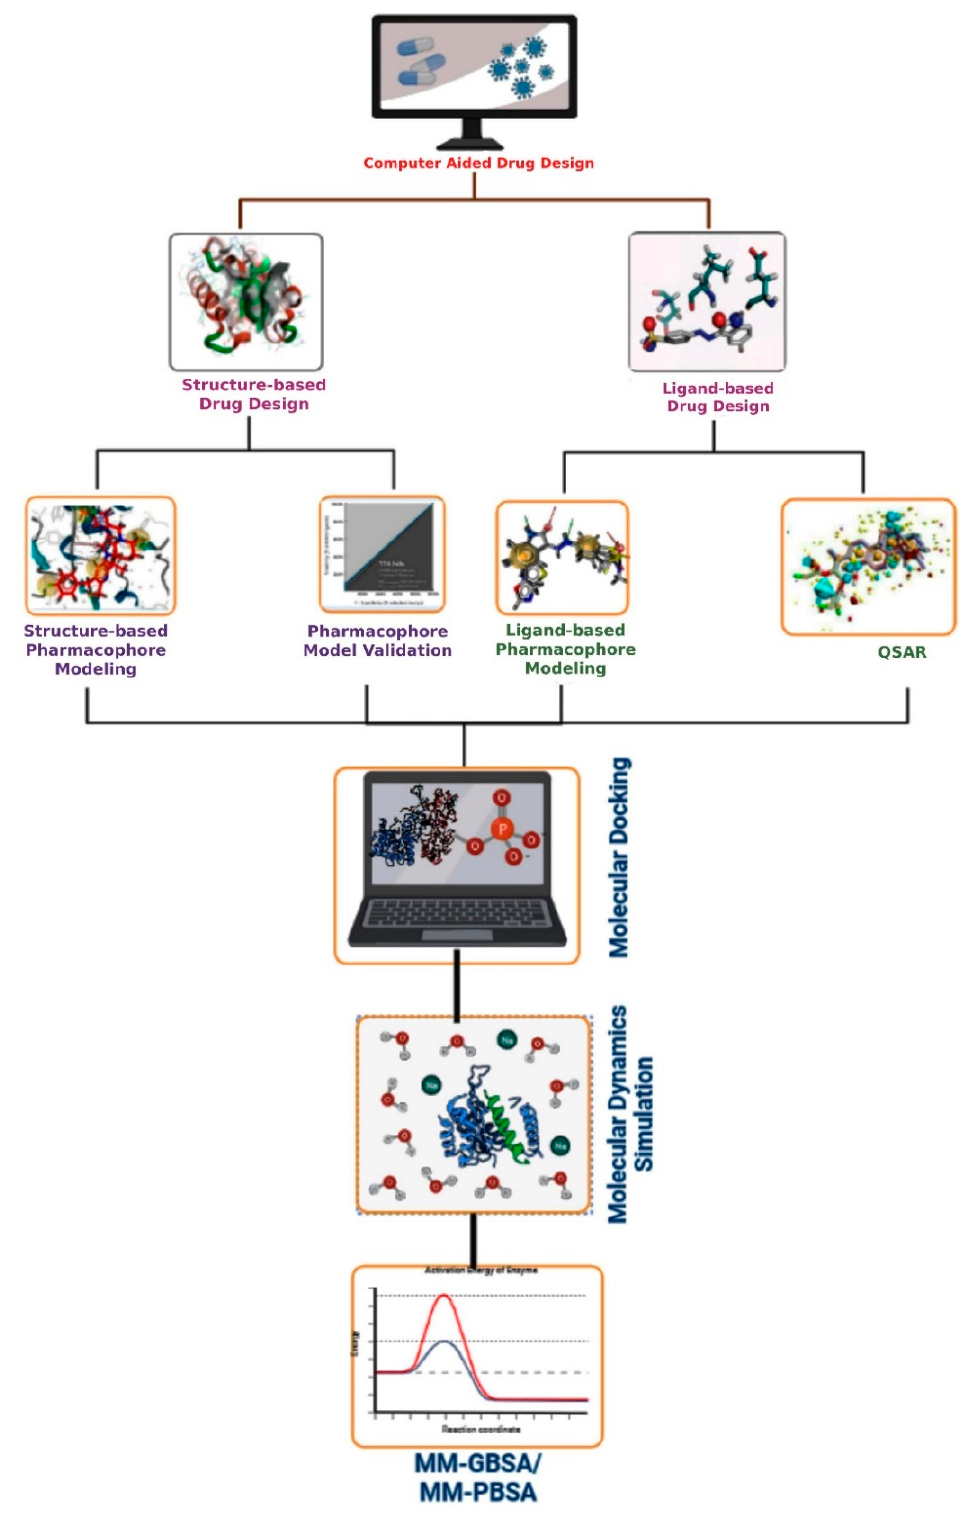
Figure 3. Representation of the basic workflow of computational drug design approaches. The CADD approaches include structure- and ligand-based drug design approaches, pharmacophore modeling, virtual screening, molecular docking, ADMET, dynamics simulation, and MM-GBSA or MM-PBSA